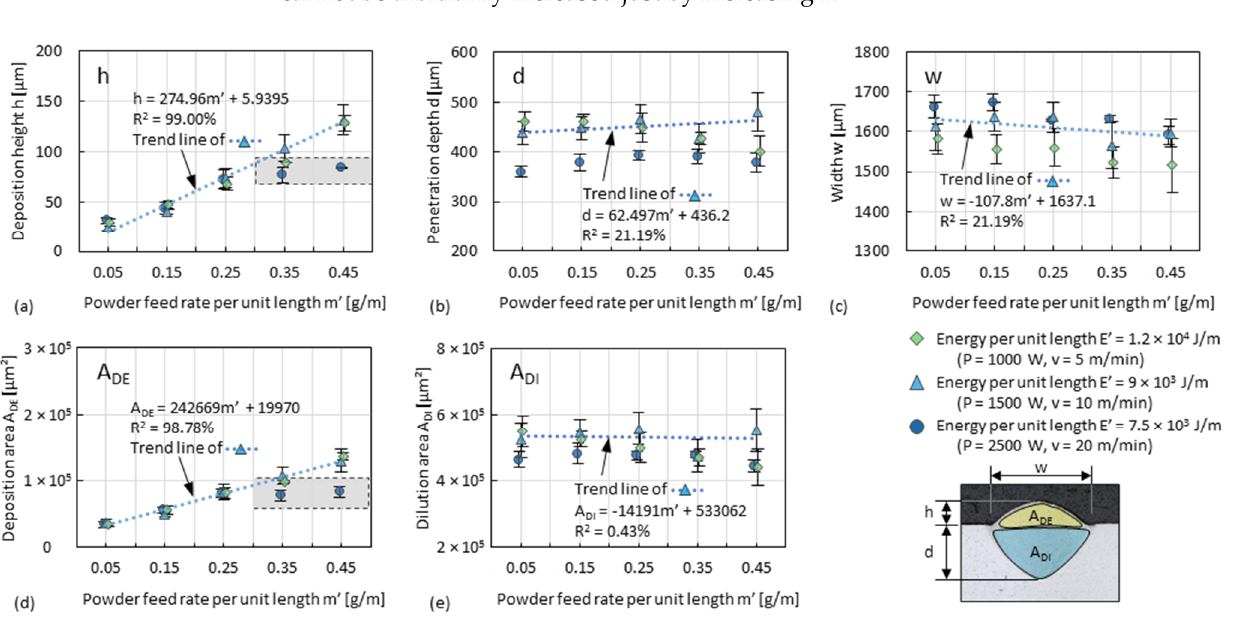
Figure 10. Plot graphs of ( a ) track height h , ( b ) melt pool depth d , ( c ) track width w , ( d ) cross-sectional area of the deposition zone A DE , and ( e ) cross-sectional area of the dilution zone A DI against powder feed rate per unit length m’ with different energy per unit length E’ . Every point refers to the average value of three measurements. R 2 refers to coefficient of determination for the trend line.